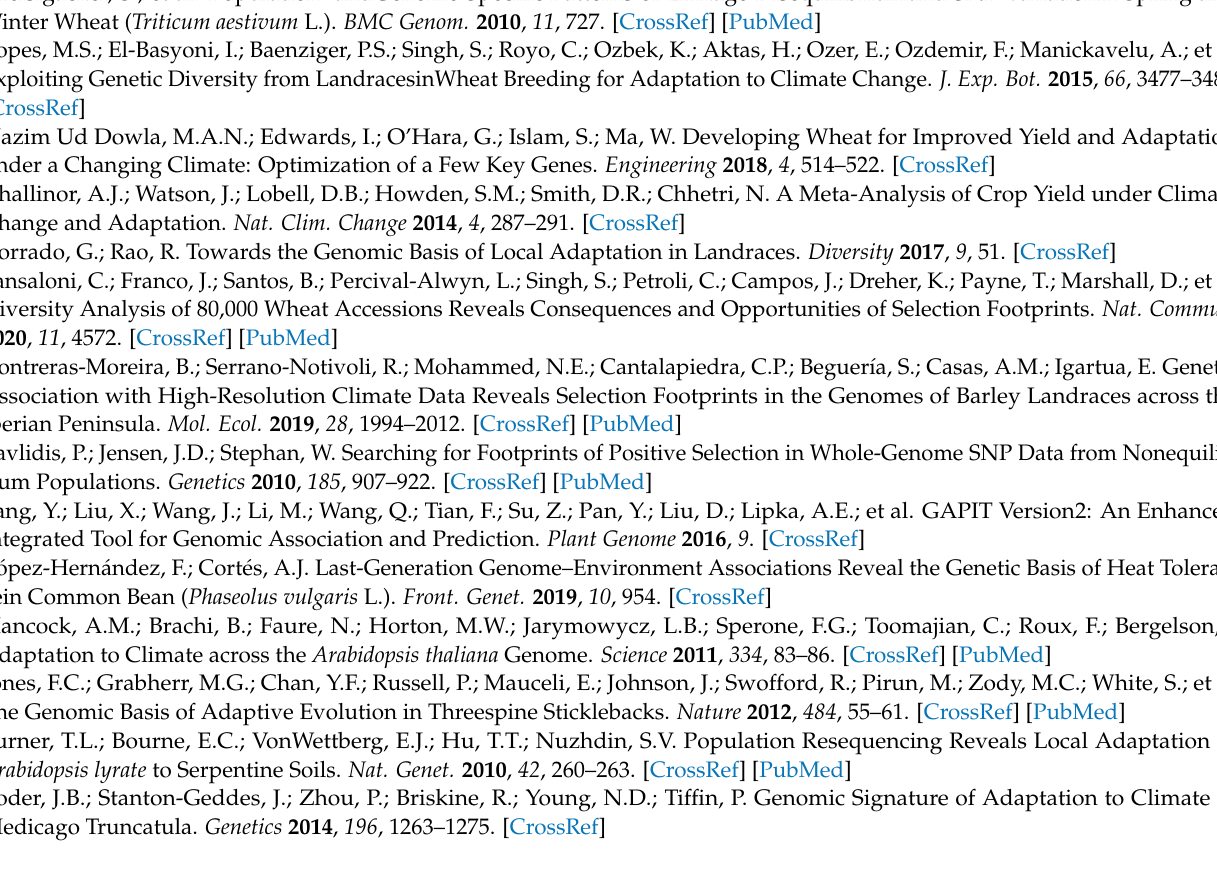
Table S2: Other genes and proteins identified by Genome–environment Association with seven climatic